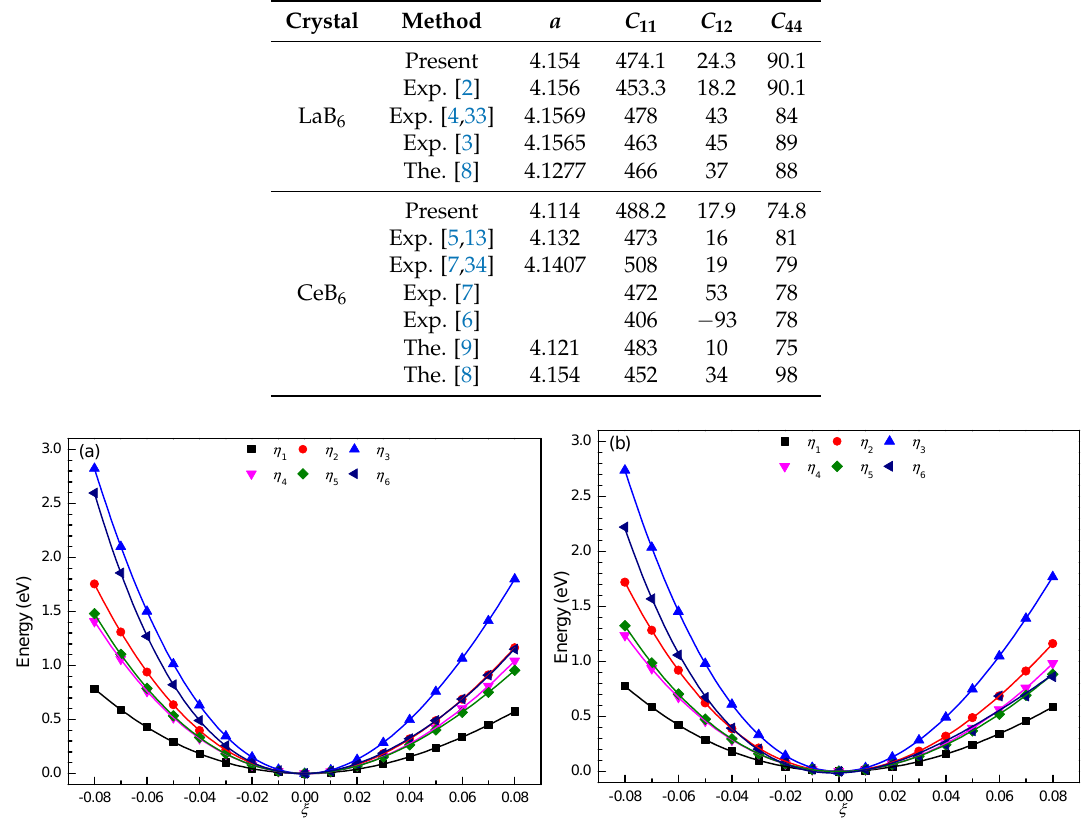
Figure 1. The strain–energy relations for ( a ) LaB 6 and ( b ) CeB 6 . The discrete points and the solid lines represent the density functional theory (DFT) results and the results of third-order polynomial fitting,